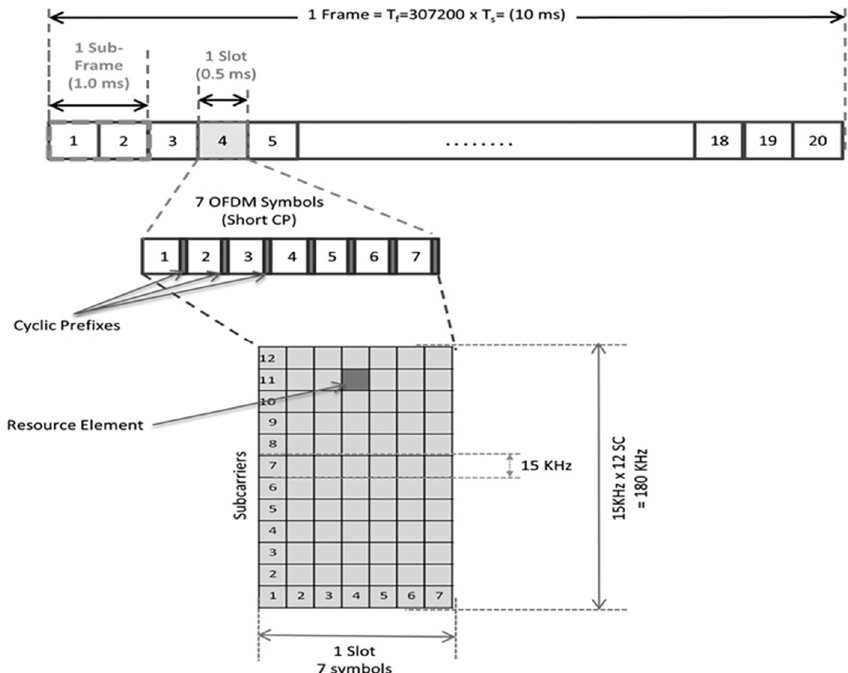
Figure 3. LTE frame structure.